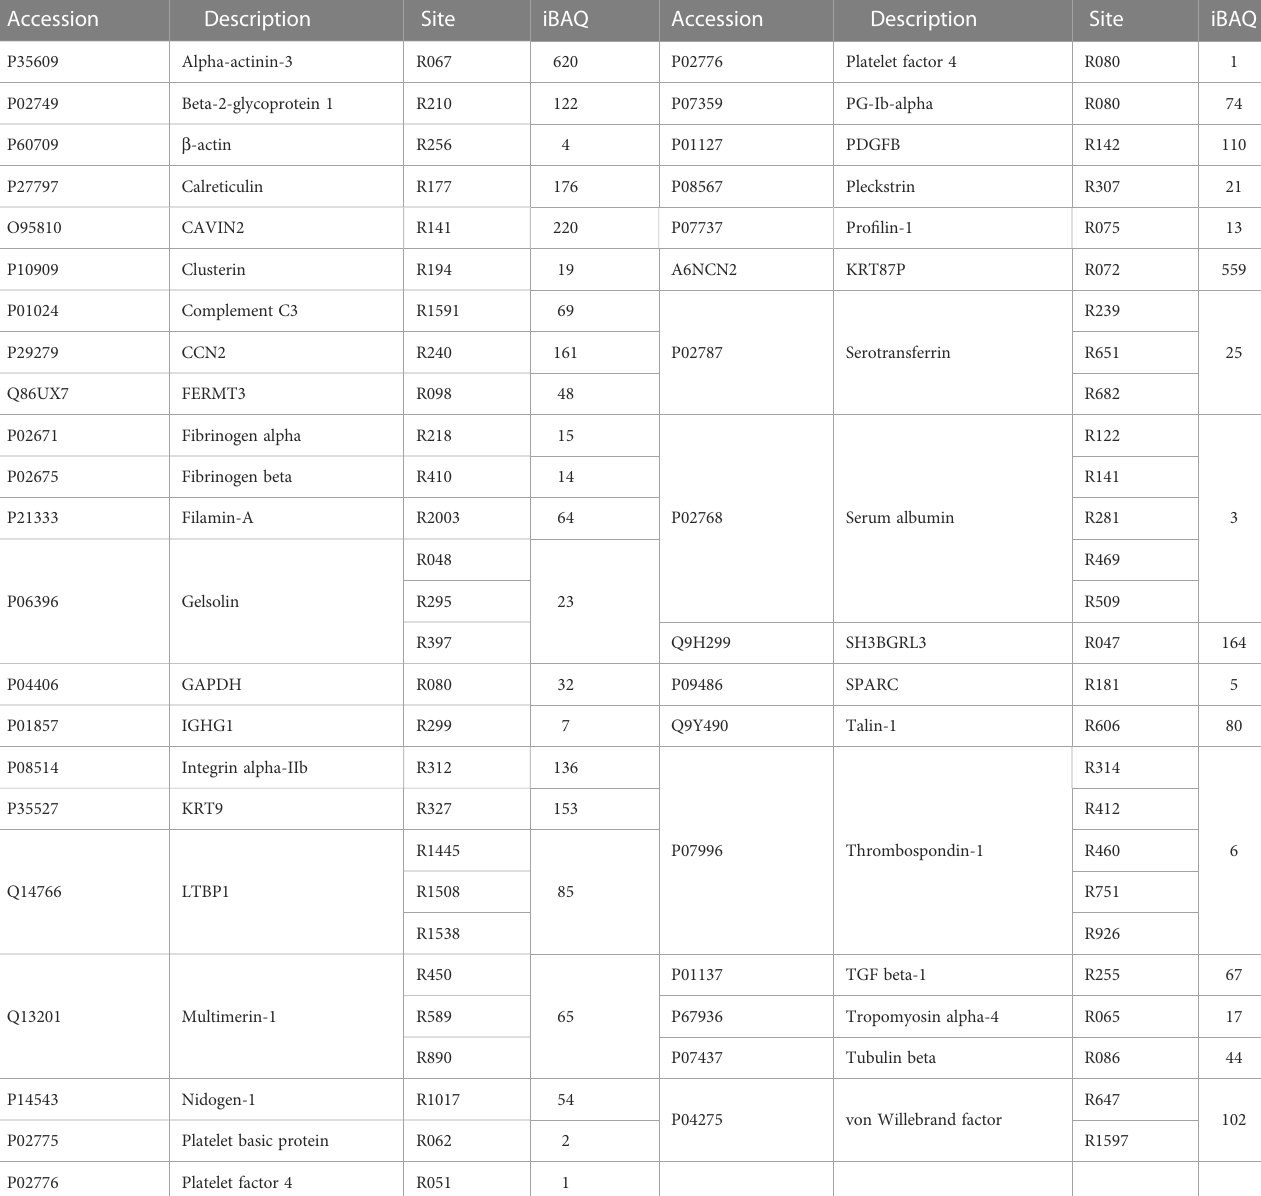
TABLE 2 Citrullination modi fi cations detected in platelet delivery